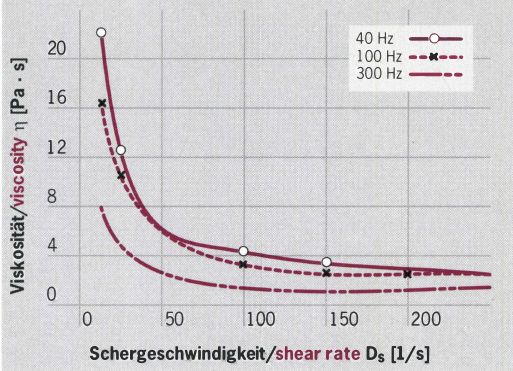
Fig. 6: Experimentally determined flow curve of an ERF (E 2 kVjmm, d 25°C} = = and an approximated flow